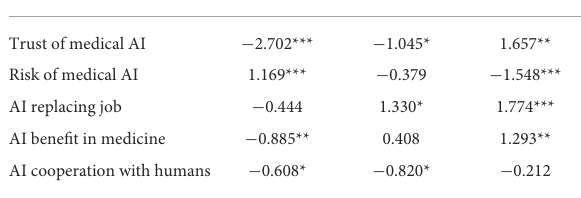
TABLE 7 Three-step results for antecedents (RESTEP) in study 2.